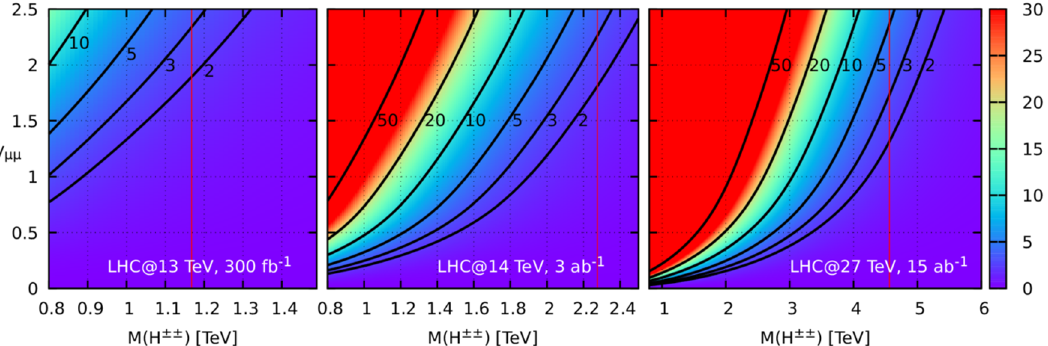
Figure 10. Number of events for the productions of doubly charged Higgs production. The solid line correspond to 2, 3, 5, 10, 20 and 50 events. The thin red lines represent the projected limits from using H (cid:6)(cid:6) -pair production [36] at 139 fb (cid:0) 1 , 3 ab (cid:0) 1 and 15 ab (cid:0) 1 for the current LHC, the High Luminosity and the High Energy upgrades